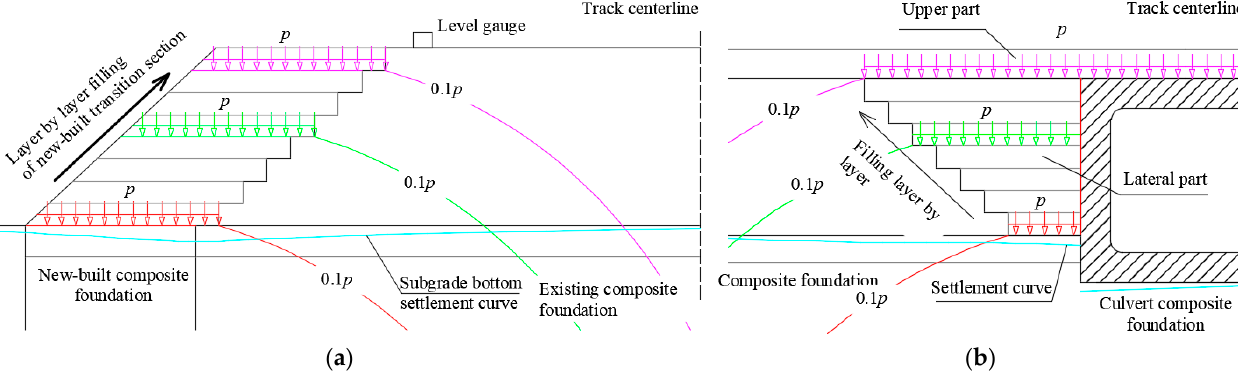
Figure 14. Schematic diagram of additional stress contour lines of uniformly distributed load at each layer in the filling stage: ( a ) schematic diagram of the cross section; ( b ) schematic diagram of the longitudinal